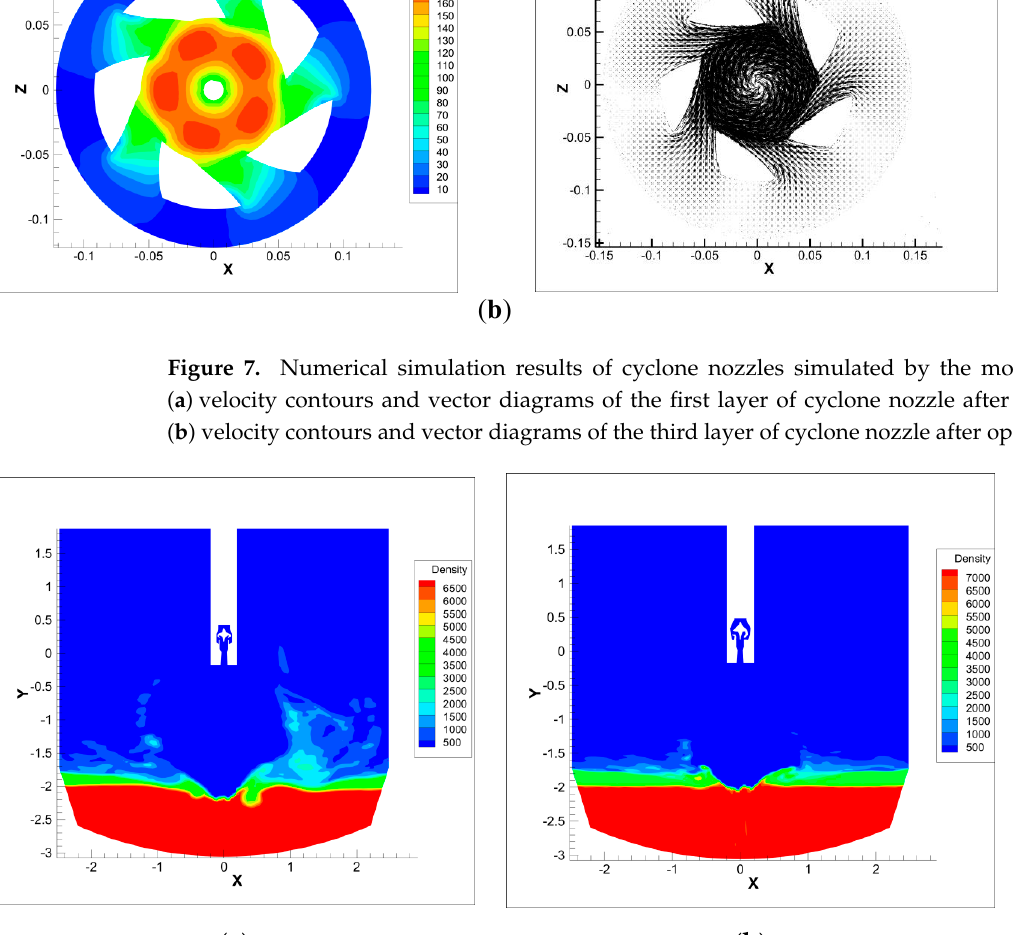
Figure 8. Comparison of interaction behavior between the pre-modified model and modified model: ( a ) density diagrams of interaction between nozzle and molten bath before optimization; ( b ) density diagrams of interaction between nozzle and molten bath after optimization.